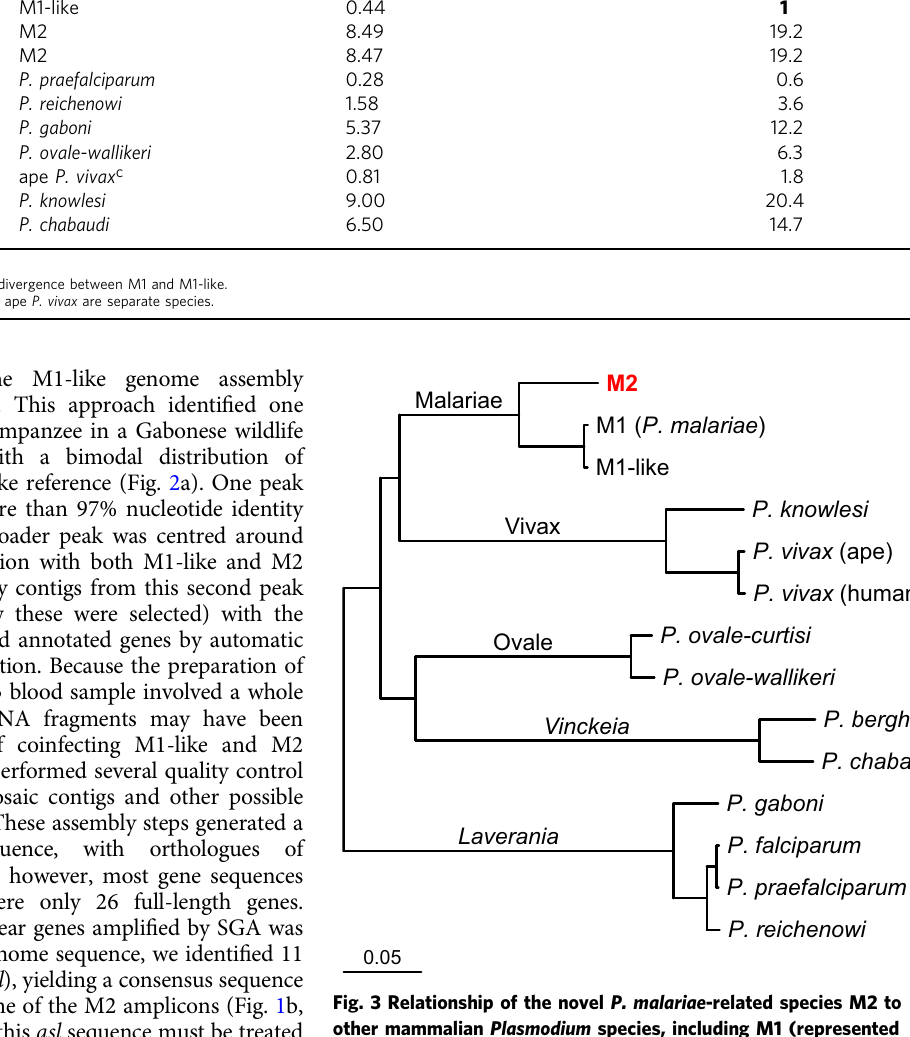
Table 1 Amino acid divergences between pairs of Plasmodium taxa. Species 1